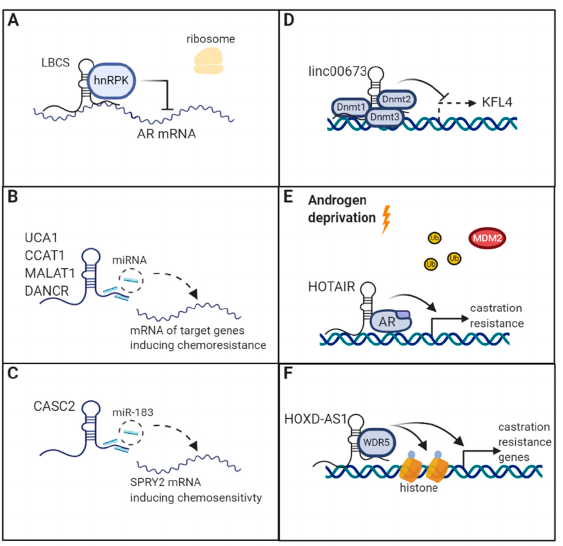
Figure 3. Examples of long non-coding RNAs (lncRNAs) and mechanisms of drug resistance in prostate cancer (PCa). ( A ) lncRNA low expression in bladder cancer stem cells (LBCS) recruits heterogeneous nuclear ribonucleoprotein K (hnRNPK) to the androgen receptor (AR) mRNA thereby